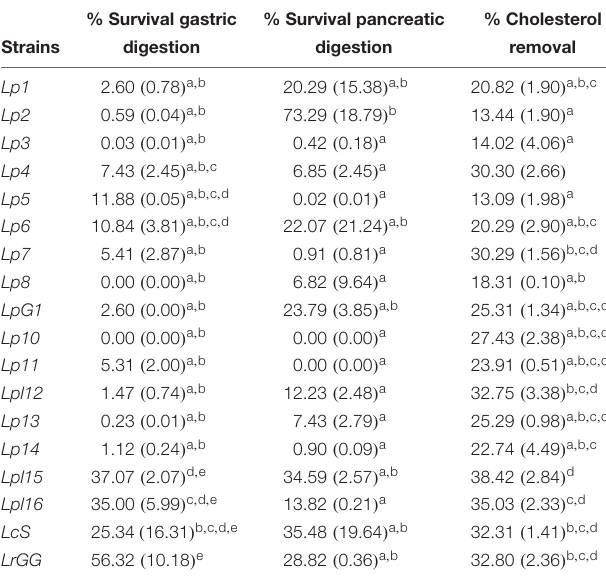
TABLE 3 | Probiotic characteristics for the 16 predominant LAB genotypes obtained in the present study.